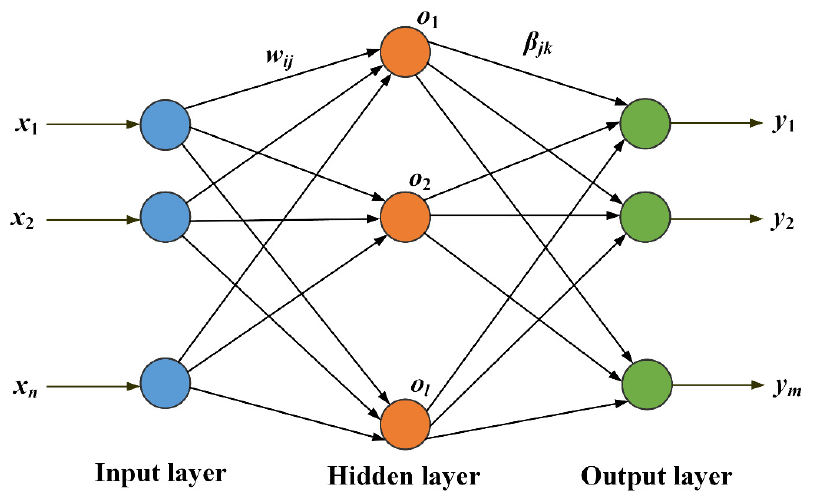
Figure 4. The topological structure of BPNN.